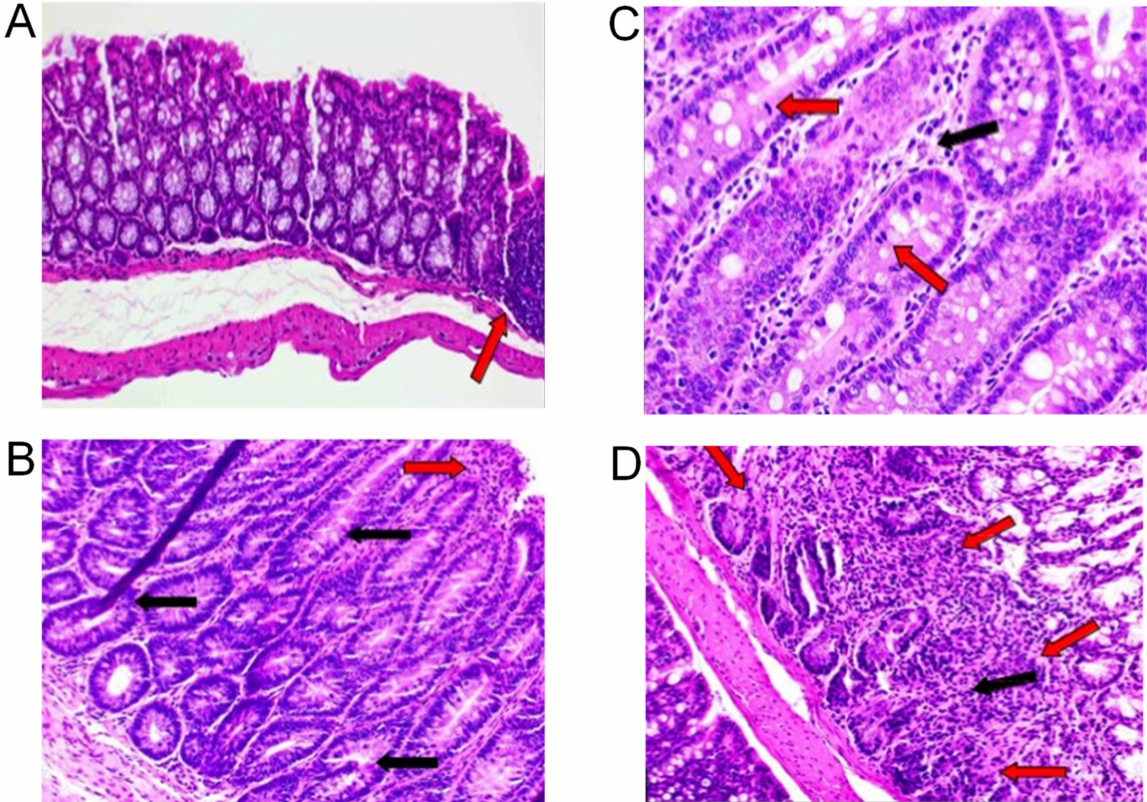
Figure 3. Histological analysis of colonic tissue in C57BL/J6 male mice fed a WD or n -6HFD. ( A ) Example of normal section of colon showing the arrangement of crypts in a 10-weeks-old male mouse fed a WD. Arrow points to a mucosal-associated lymphoid tissue (MALT) (20 × magnification). ( B ) Representative photomicrograph showing a focus of hyperplasia characterized by elongated and/or tortuous crypts lined with epithelial cells exhibiting increased basophilia and cellular stratification. Black arrows point to the hyperplastic crypts. Red arrow points to the minimally-inflamed surface epithelium associated with mononuclear infiltrates. Slide is from a 16-weeks-old mouse fed the WD (20 × ). ( C ) Example of hyperplastic crypts showing mitotic figures (red arrows) and mononuclear inflammatory cells (black arrow) that appear to expand the lamina propria around the crypts. The slide is from a 16-weeks-old C57BL/J6 male mouse fed the n -6HFD (40 × ). ( D ) Example of disruption of normal crypt architecture and expansion of the deeper lamina propria by mononuclear inflammatory cells and mild fibrosis (black arrow). Red arrows outline the perimeter of the hyperplastic lesion. The slide is from a 16-weeks-old C57BL/J6 male mouse fed the n -6HFD (20 ×